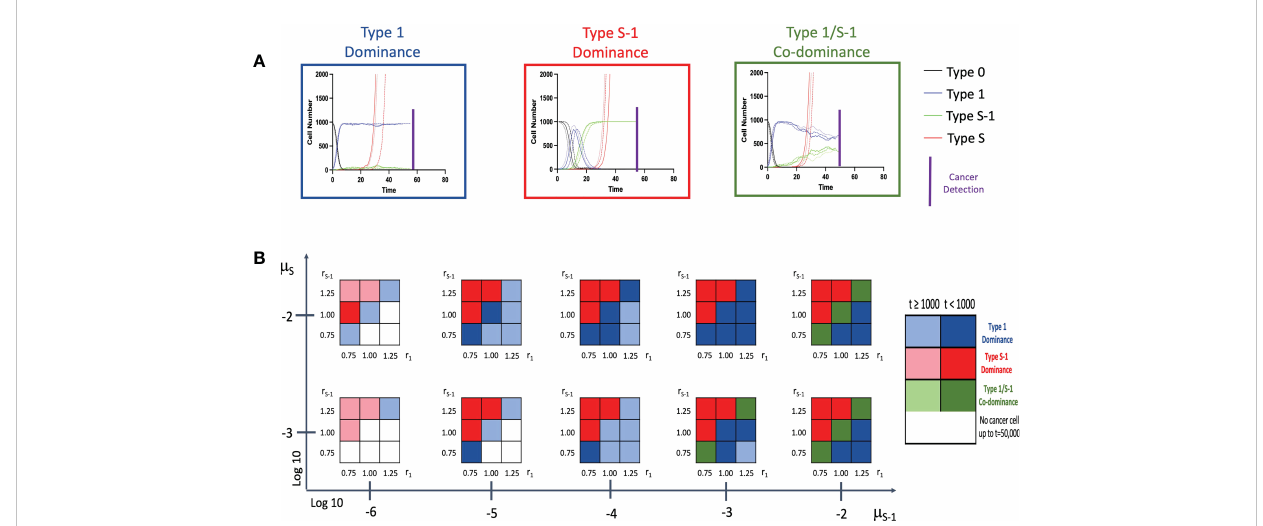
FIGURE 2 Patterns of tissue composition at cancer initiation (A) Simulation studies without spatial structure show three patterns of cancer initiation. For each pattern, black, blue, green and red curves indicate Type 0, Type 1, Type S -1 and Type S cells, respectively. Each parameter set was simulated in triplicate (Joined, dashed, and long-dashed lines). (B) Panel showing several patterns of tissue composition and time to detection using combination of various parameter sets. Cell type “ Dominance ” indicates >90% of a particular cell type at cancer detection. “ Co-dominance ” refers to 2 cell populations with >40% or 3 cell populations with >30% at cancer detection. Parameter values used are: N = 1,000; d = d s = 1.0; r 0 = 1.0; r 1 = 0.75, 1.00 and 1.25; r S -1 = 0.75, 1.00 and 1.25; r S = 1.5; m 1 = 0.001 and 0.01; m S -1 = 0.000001, 0.00001, 0.0001, 0.001 and 0.01; m S = 0.001 and 0.01. Note: Mutation rate, m 1 , does not impact the results and is not